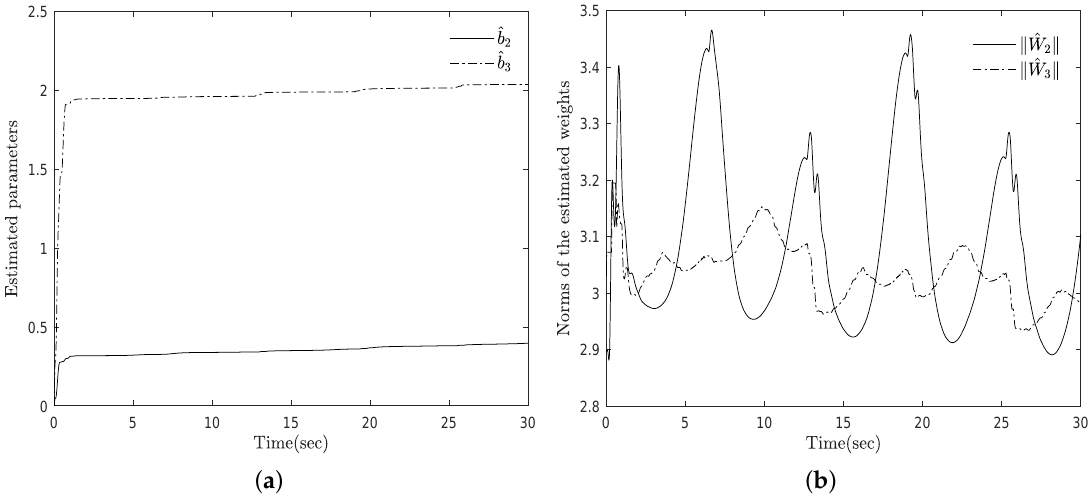
Figure 7. Estimation results of the proposed approach for Example 2 ( a ) ˆ b i ( b ) (cid:107) ˆ W i (cid:107) for i =